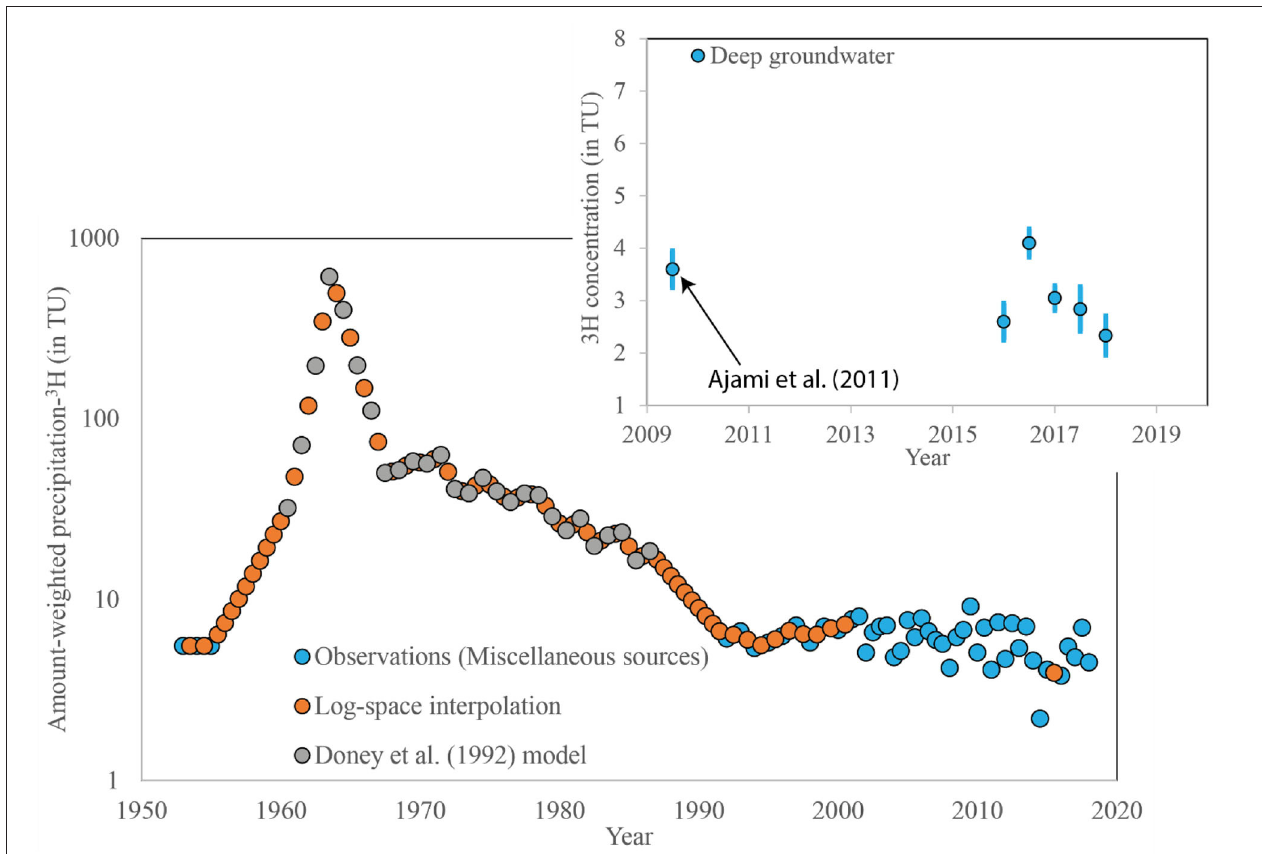
FIGURE 3 | Amount-weighted 3 H concentration in precipitation (data from Eastoe et al., 2004; Eastoe, unpublished data; Supplementary Figure 2 ; The Environmental Isotope Laboratory, The University of Arizona), and 3 H concentrations in deep groundwater (blue points; a combination of MG-Weir site and Pigeon Spring; see Figure 1 for their locations). Different colored points in the base plot show data sources (see also Supplementary Figure 2